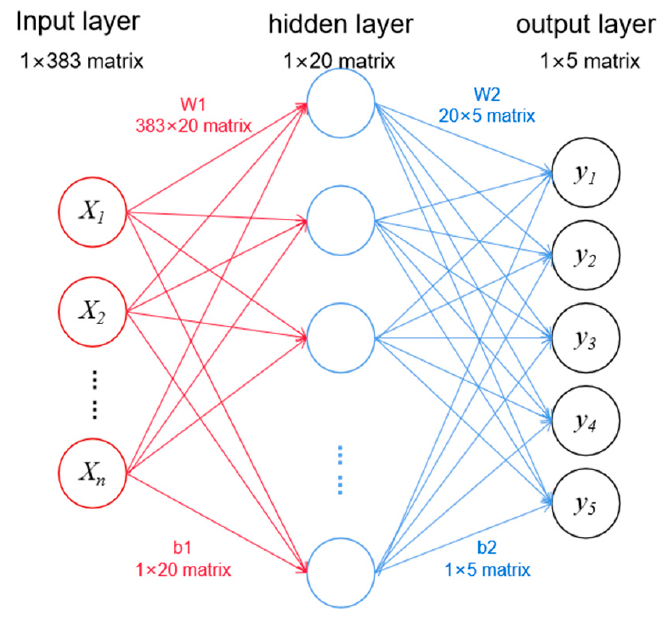
Figure 8. Driving style recognition model neural network topology map.